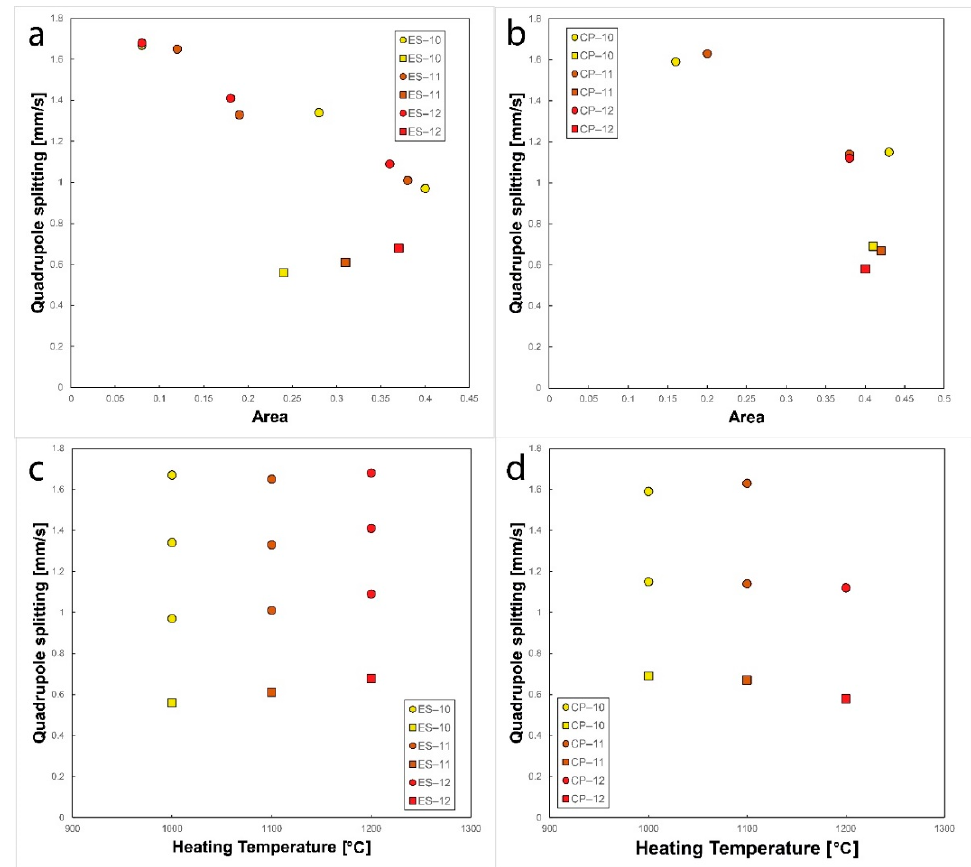
Figure 10. Comparison of quadrupole splitting and area of doublets for ( a ) ES and ( b ) CP samples and quadrupole splitting and heating temperature for ( c ) ES and ( d ) CP samples. and quadrupole splitting and heating temperature for ( c ) ES and ( d ) CP